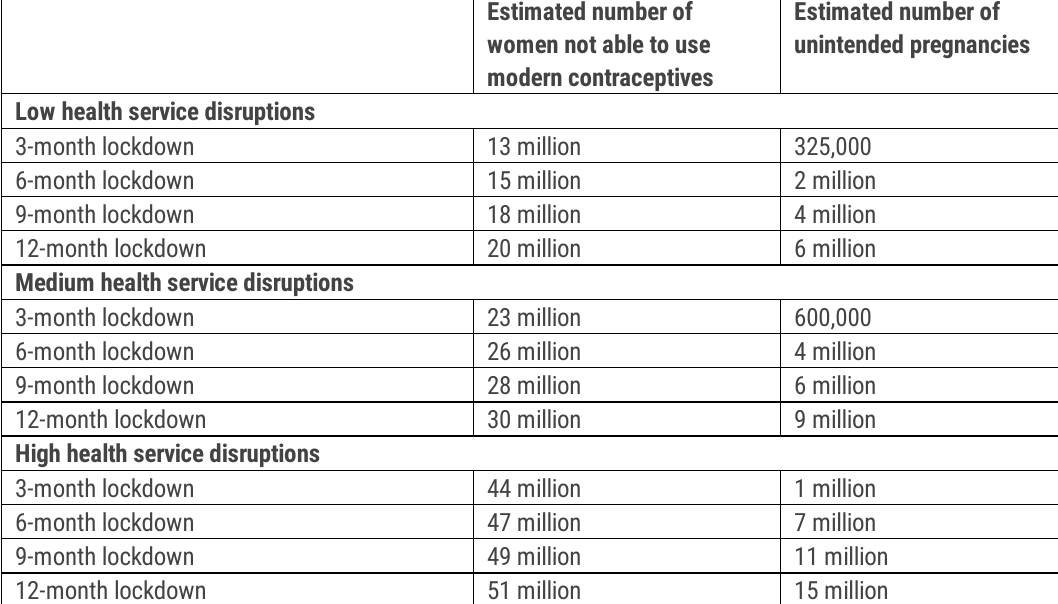
Estimated number of unintended